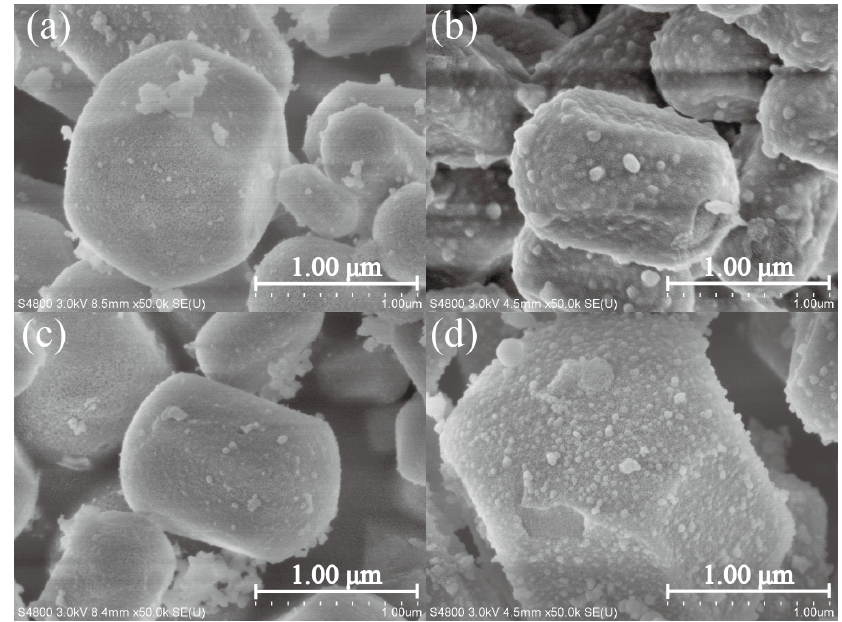
Figure 4. Scanning Electron Microscope (SEM) images of MCM-41 ( a ); Sal-MCM ( b ); ZnO-MCM-0 ( c ); and ZnO-MCM-9 ( d ).